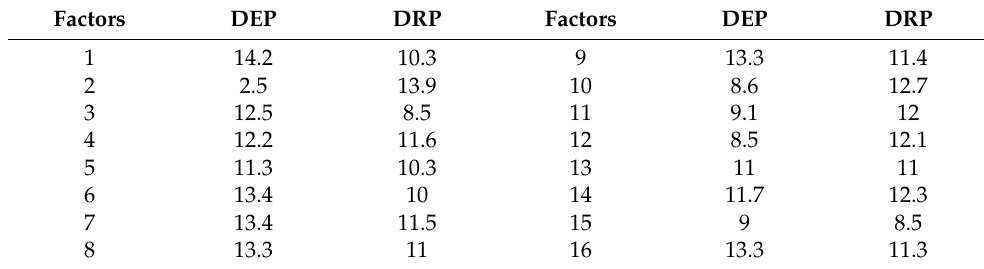
Table 5. Driving power (DRP) and dependence power (DEP) on stabilised FDRM.